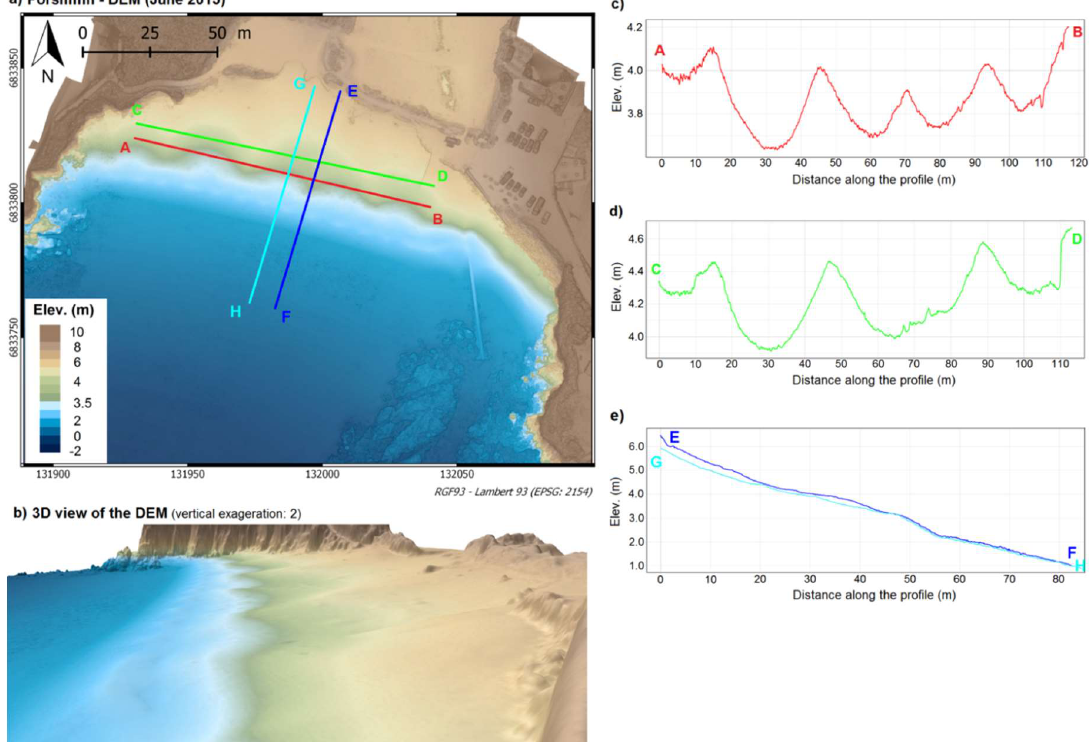
Figure 6. ( a ) Portion of the digital elevation model (DEM) computed from the photographs collected on the 16 June 2015. ( b ) 3D view of the DEM showing the beach cusps (vertical exageration: 2). ( c , d ) Alongshore beach vertical profiles showing the beach cusp morphology. ( e ) Cross-shore profiles showing differences in beach face gradient between embayments and horns.